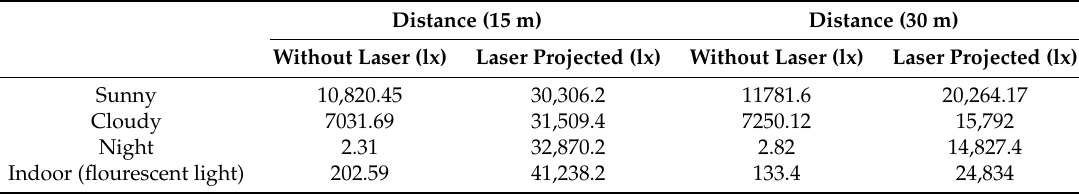
Table 2. Measurement of light intensity in various